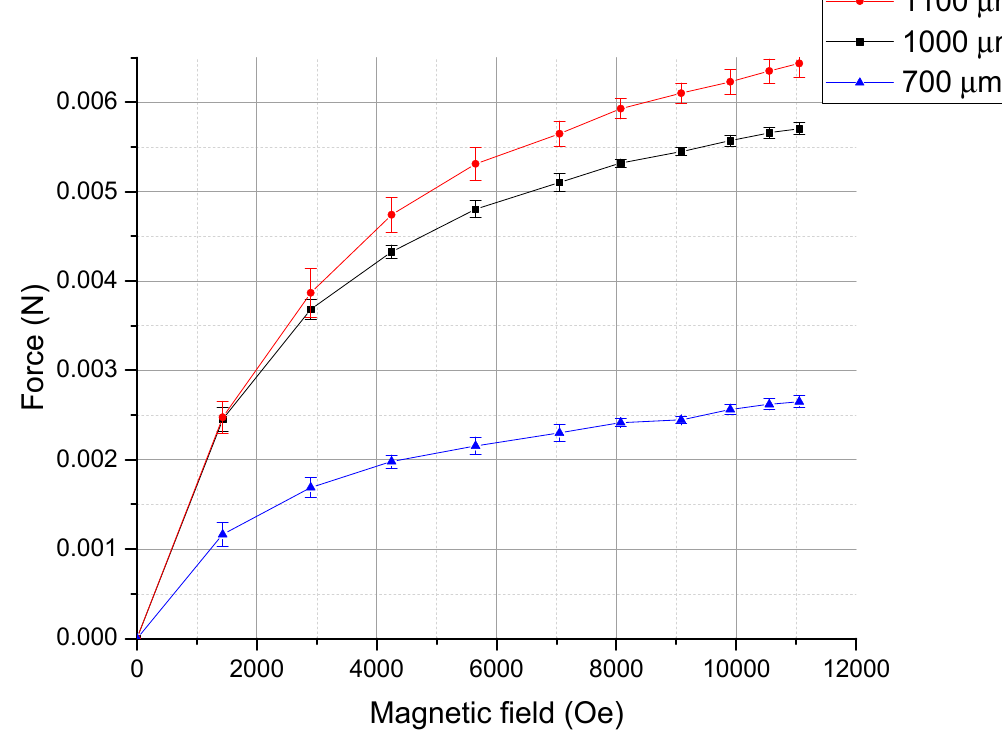
Figure 11. Generated forces of Tb 0.36 Dy 0.64 Fe 1.9 obtained from three cantilevers with lengths 700, 1000, 1100 µm.